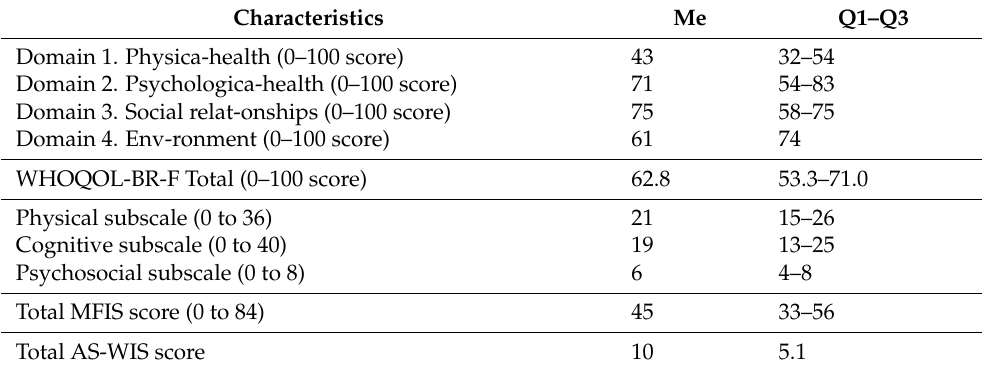
Table 2. The QoL, level of fatigue and risk of work disability in the patients studied.